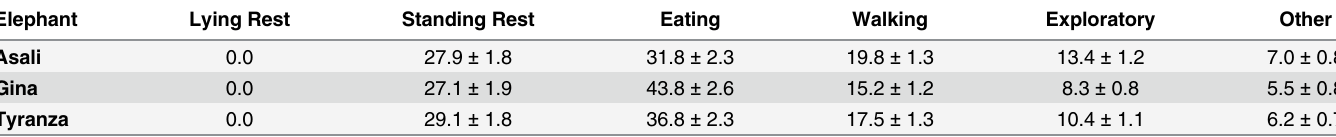
Table 1. Percent of diurnal, outdoor behavioral scans (mean ± standard error) the elephants spent engaged in each behavioral category through- out the entire duration of the study. Elephant Lying Rest Standing Rest Eating Walking Exploratory